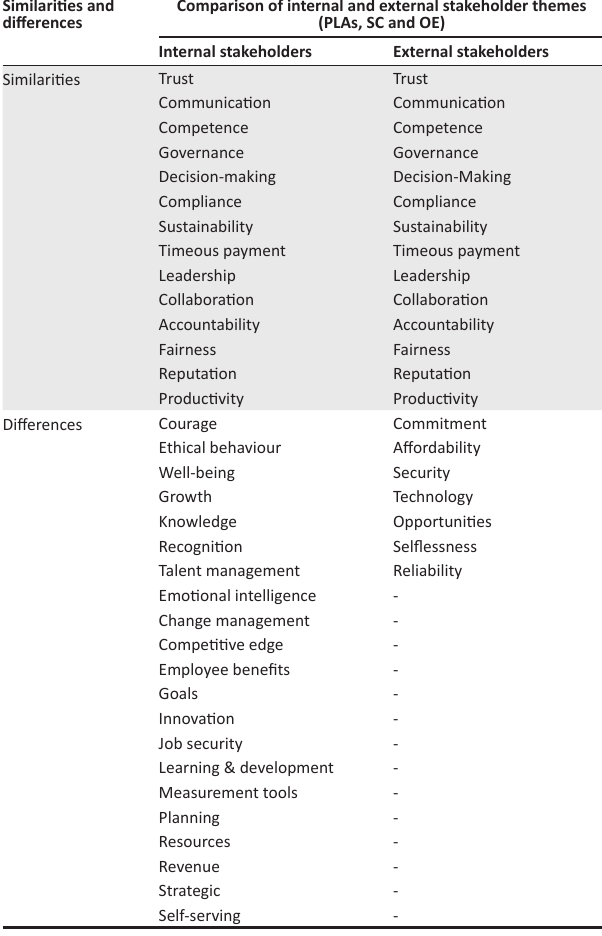
TABLE 1-A3: Illustration of similar and different themes for internal and external stakeholders.